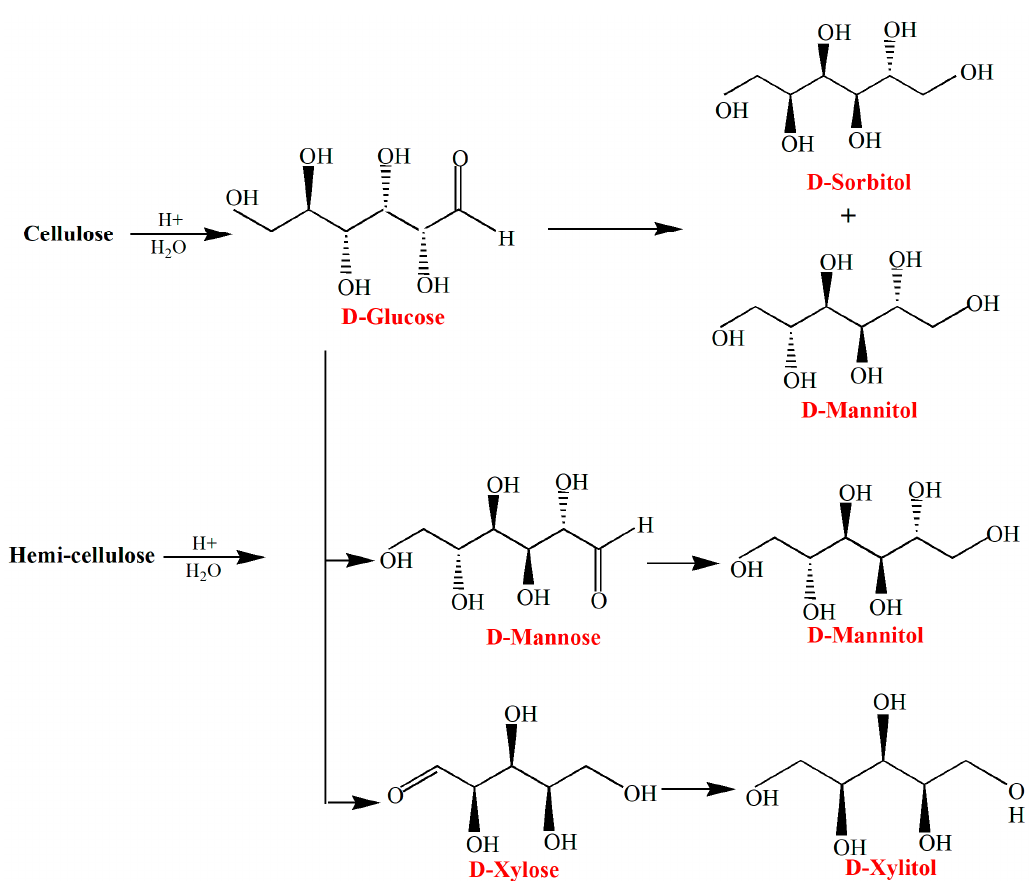
Figure 11. Sugar alcohols from cellulose and hemicelluloses [185–186,195,198].